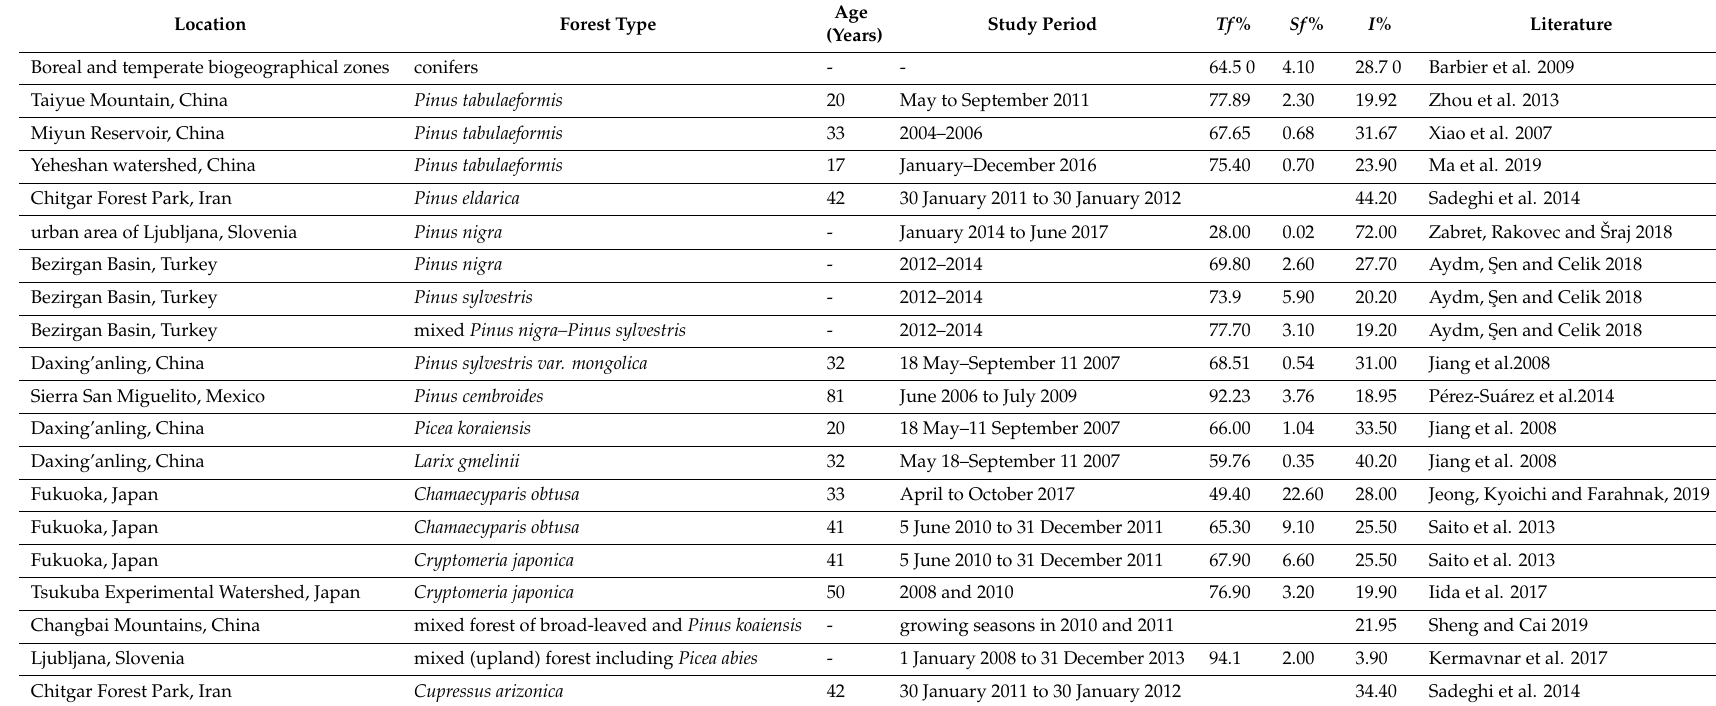
Table 7. Rainfall partitioning characteristics of conifer forests in di ff erent